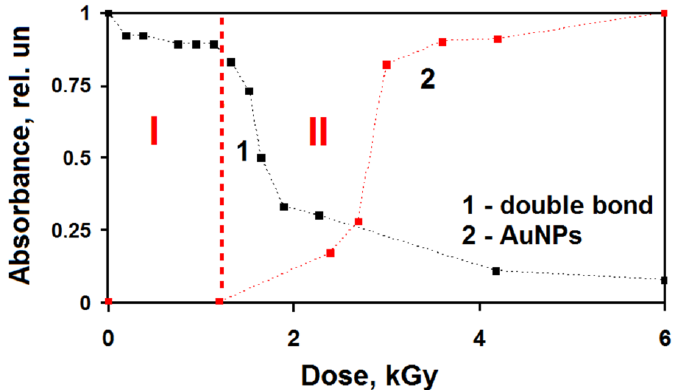
Figure 8. A sigmoidal (S-shaped) kinetics of nanoparticle growth and an “S-reverse” kinetics of the monomer consumption (samples prepared at the ratio of 80/1) .